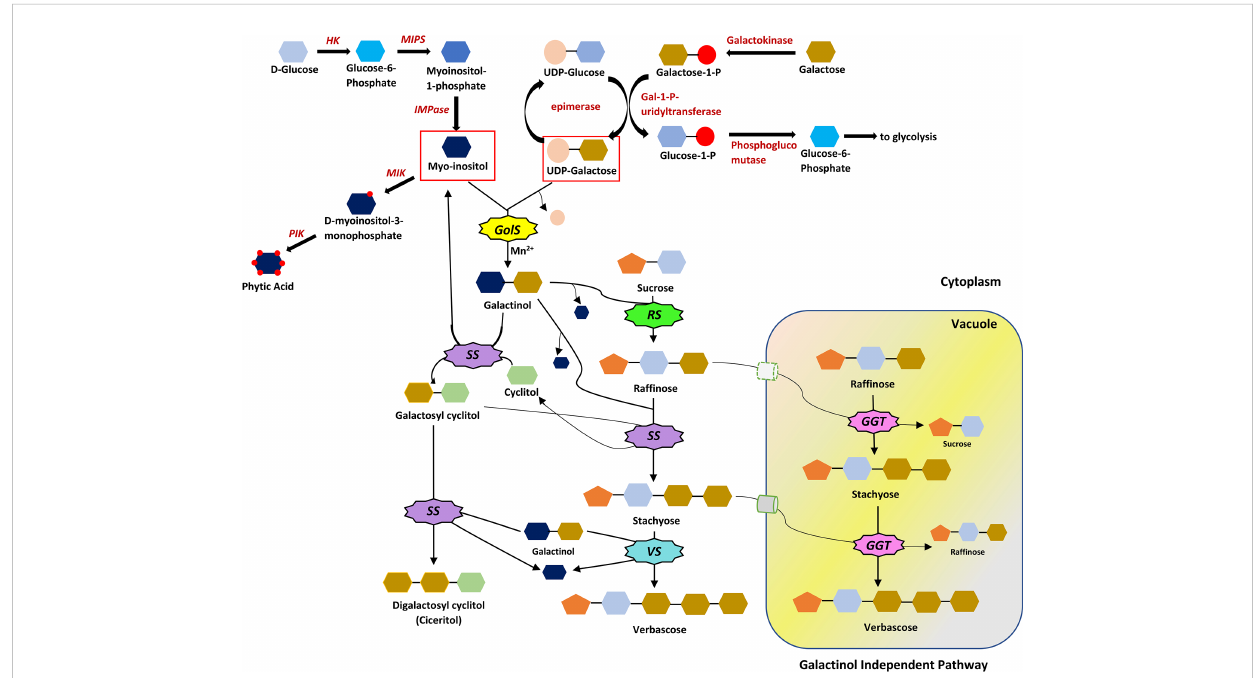
FIGURE 2 The RFOs biosynthetic pathway. Myo-inositol and UDP-Galactose serve as the precursors for galactinol. The reaction is catalysed by galactinol synthase ( GolS ) and Mn 2+ as a cofactor. Galactinol is the galactose donor to sucrose, forming raf fi nose with the help of raf fi nose synthase ( RS ). The addition of galactose moiety to raf fi nose is catalysed by stachyose synthase ( SS ), producing stachyose. SS has a broad substrate speci fi city, catalyzing the production of ciceritol in some plants. Verbascose synthase ( VS ) catalyses the formation of verbascose in the galactinol-dependent pathway. A galactinol- independent pathway also exists in some crops or even in different tissues of the same crop, where galactan: galactan galactosyltransferase ( GGT ) catalyses the formation of RFOs, utilizing the galactose moiety from lower order RFOs. All the reactions are reversible in galactinol-dependent and independent pathways. HK , Hexokinase; MIPS , Myoinositol-1-Phosphate Synthase; IMPase , Inositol mono phosphatase; MIK , Myoinositol Kinase; PIK , Phosphoinositol